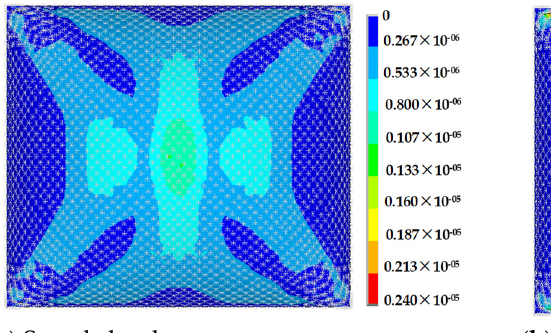
Figure 7. Computational Simplified Model.